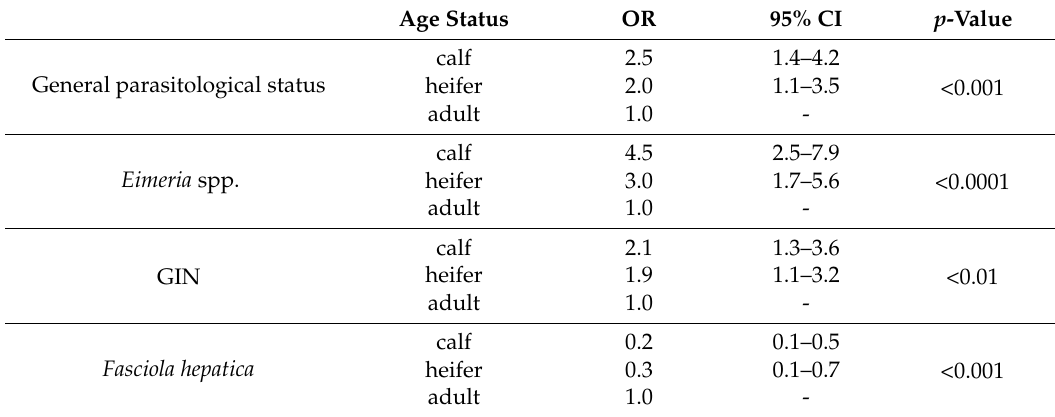
Table 2. Odds ratios (OR) and 95% confidence intervals (CI) for the risk factor age status of the animal with regard to general parasitological status, Eimeria spp., gastrointestinal nematodes (GIN) and Fasciola hepatica